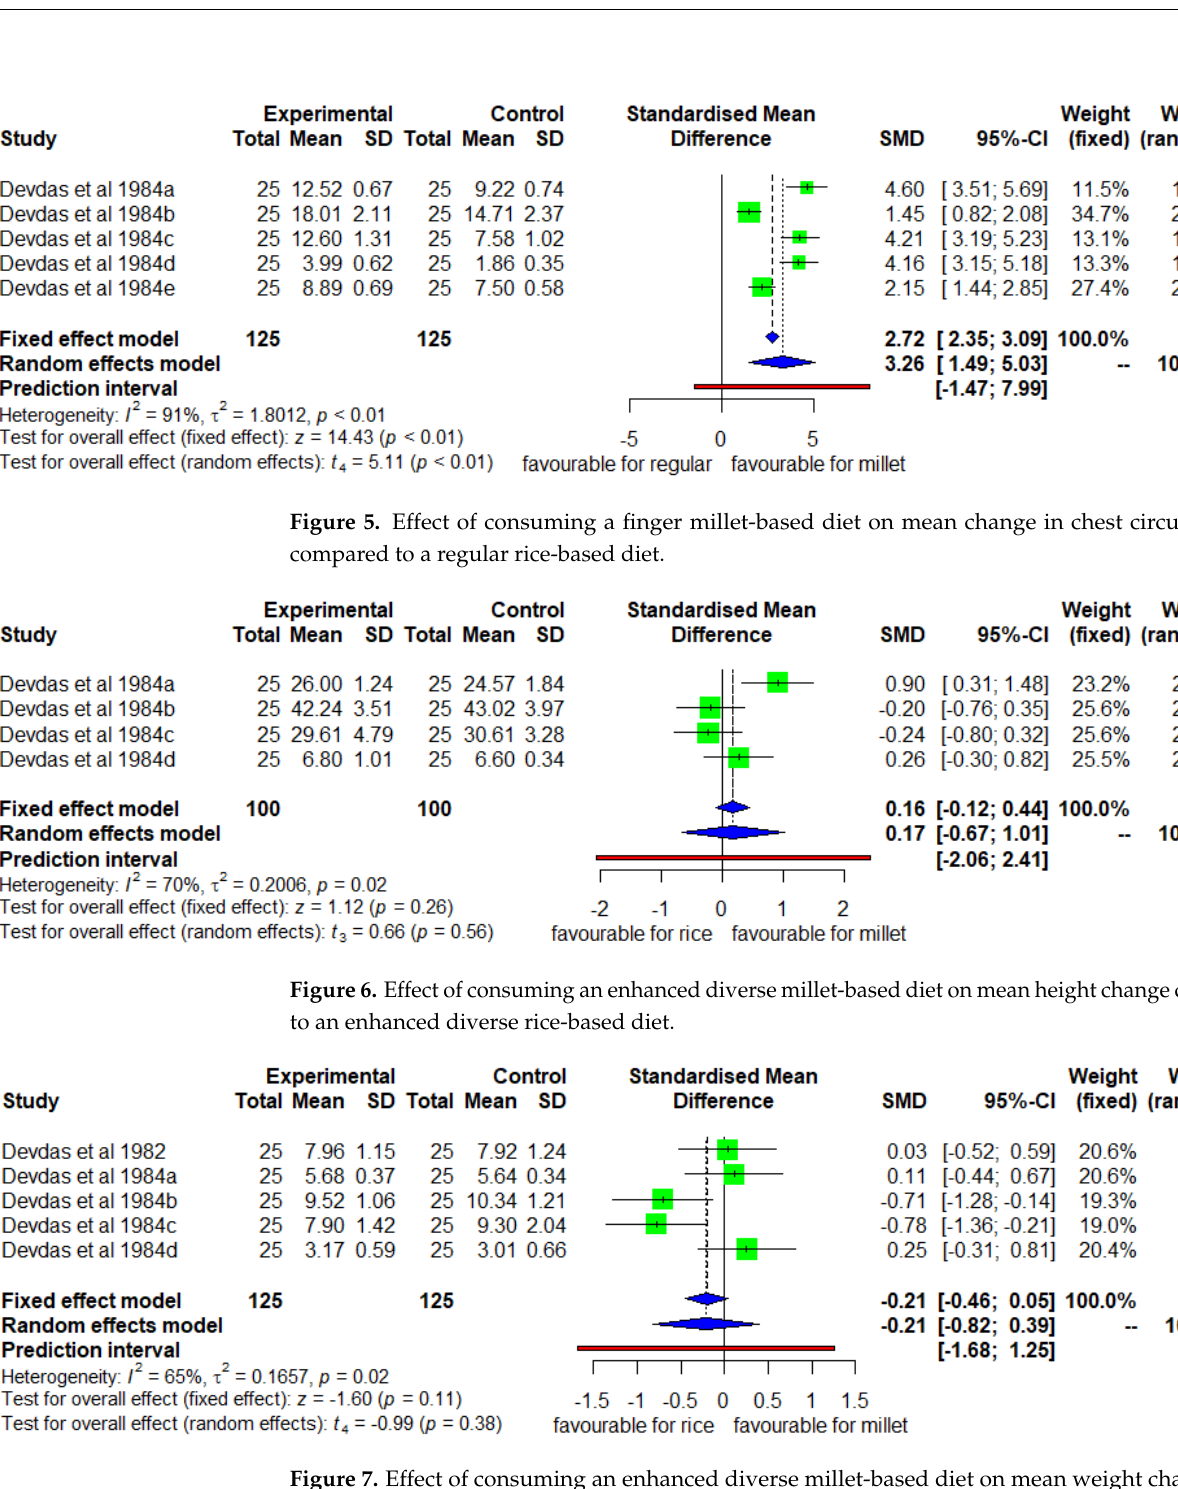
Figure 8. Effect of consuming an enhanced diverse millet-based diet on mean MUAC change com- pared to an enhanced diverse rice-based diet. 3.8. Mean Changes in Chest Circumference (Enhanced Diverse Millet Diet vs. Enhanced Diverse Rice Diet) Figure 9 shows the mean changes in chest circumference. In the fixed effect model, the DID was positive and significant ( p < 0.01) high heterogeneity (I 2 = 82%) among studies and SMD of 0.37 (95% CL of 0.08; 0.67). However, the mean increase in chest circumference was only slightly higher (2%) in the intervention group consuming a finger millet than in the control group consuming a rice-based diet.